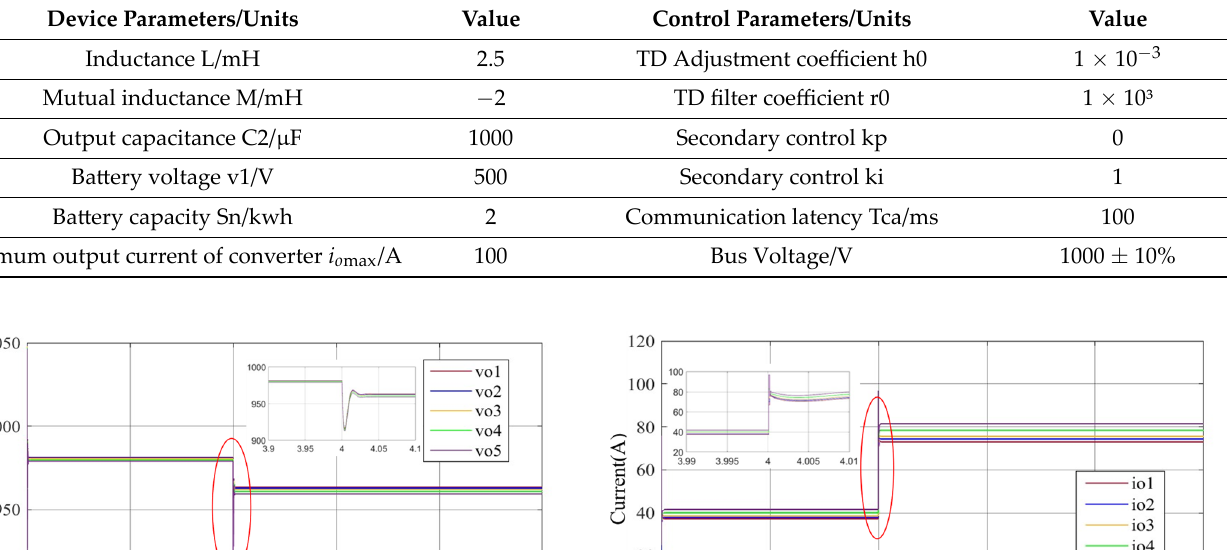
( d ) Figure 7. Network dynamics under different topologies. ( a ) Line; ( b ) ring; ( c ) star; ( d ) full. 5. Simulation and Analysis Refer to 《 IEEE Recommended Practice for 1 kV to 35 kV Medium-Voltage DC Power Systems on Ships 》 and the actual case information for DC ships in the literature [31]. The model was established in MATLAB/Simulink, and the proposed method was simulated and verified with a simulation step size of 5e-5s. Additionally, the line impedance values are as follows: R1 = 0.08 Ω , R2 = 0.07 Ω , R3 = 0.06 Ω , R4 = 0.04 Ω , and R5 = 0.02 Ω . Droop coefficient Rv is set to 0.5. The rest of the simulation circuit parameters are shown in Table 1. Table 1. Circuit and control parameters. Device Parameters/Units